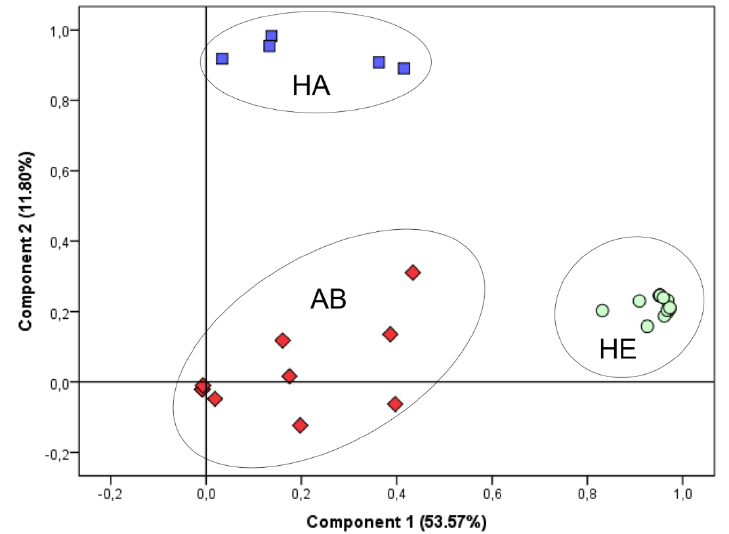
Figure 4. PCA (Principal Component Analysis) plot depicting the differentiation of group of individuals by VOC profiles; Assigned clusters: healthy controls (HE), patients with submandibular abscess (AB) and halitosis (HA).